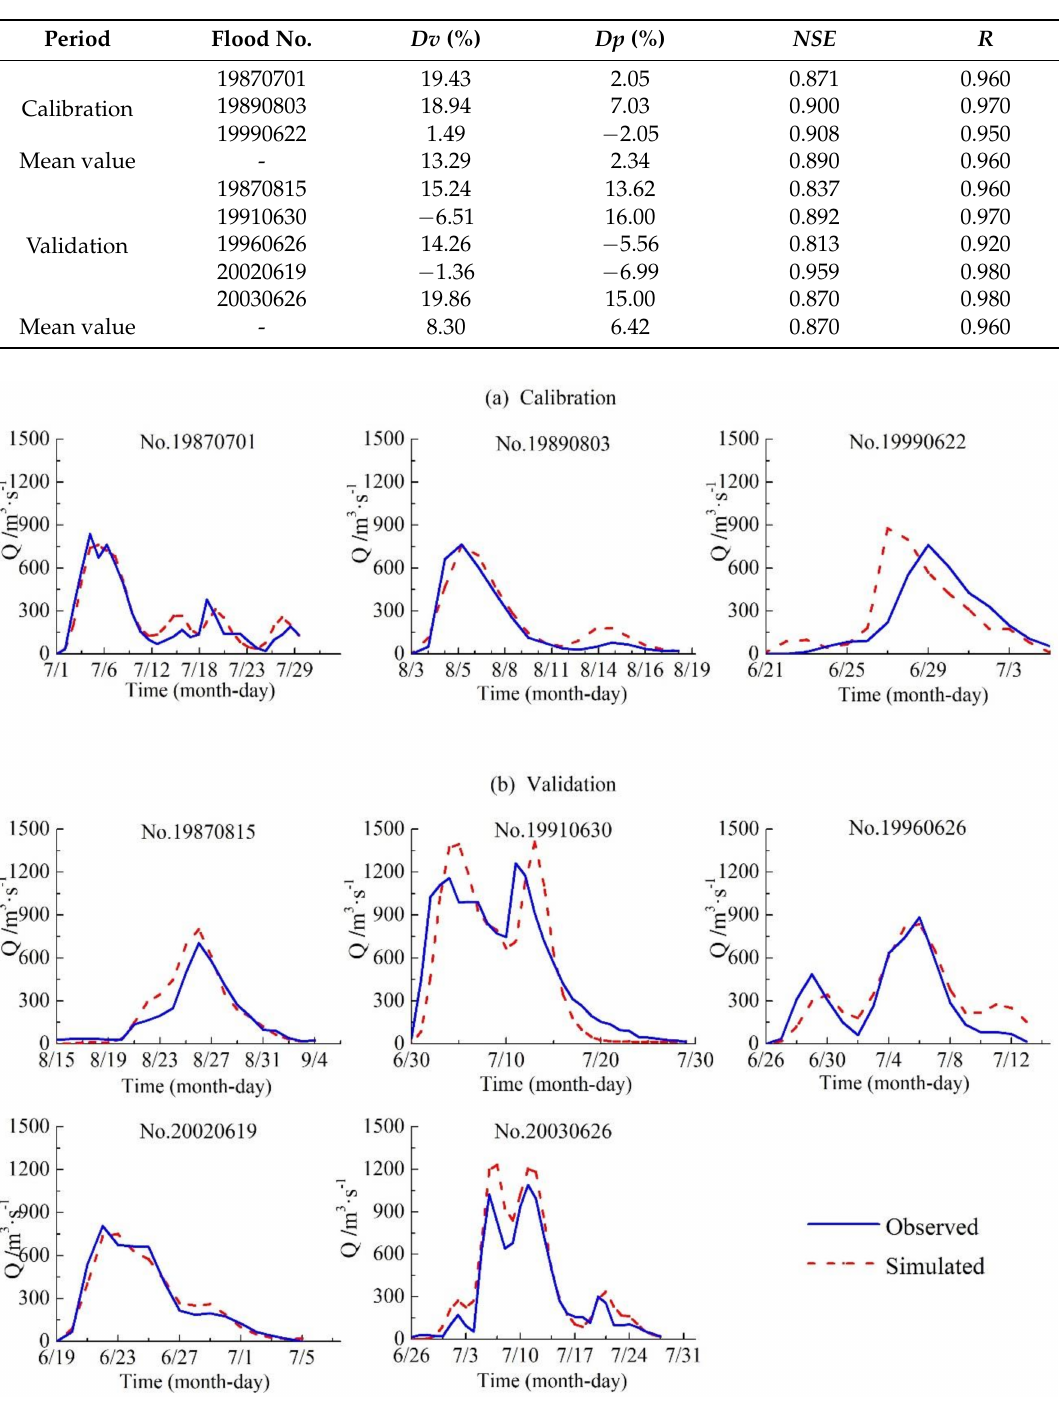
Table 4. The results of the four evaluation criteria of HEC-HMS model without polder for the selected eight flood events at the daily step in the calibration and validation period.